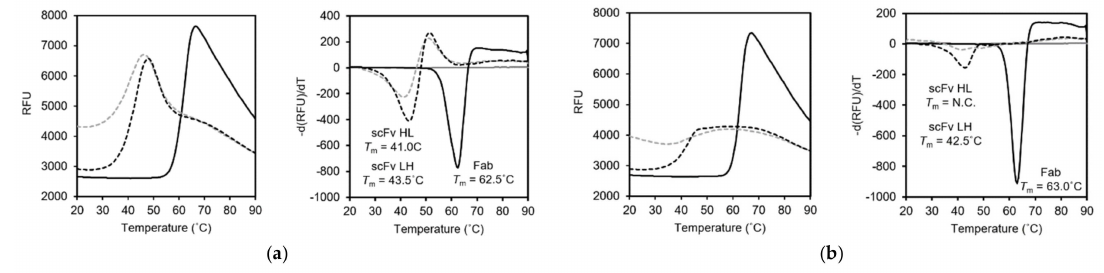
Figure 4. Thermal stability assay of scFvs and Fabs. ( a , b ) DSF analyses of 15–13 ( a ), and 12–22 ( b ). DSF plots (raw data, left) and plot of derivative fluorescent-based signal against temperature (right) are represented. Solid lines represent Fab fragment. Dotted lines represent scFv HL (gray) and LH (black). Tm values were measured from the curve minima. N.C. means “could not be